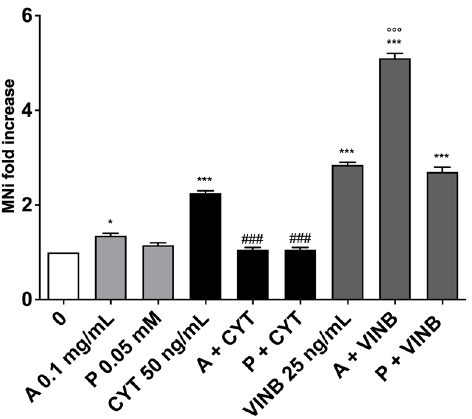
Figure 8. MNi fold increase on TK6 cells after 3 h treatments with A. leucotrichus (A) or perillaldehyde (P) followed by 23 h of recovery in the complete medium at the indicated concentrations in the presence or absence of CYT (clastogen) or VINB (aneugen) compared to the untreated cultures (0) and the relative positive controls. * p < 0.05; *** p < 0.001 vs. 0; °°° p < 0.001 vs. VINB; ### p < 0.001 vs. CYT.